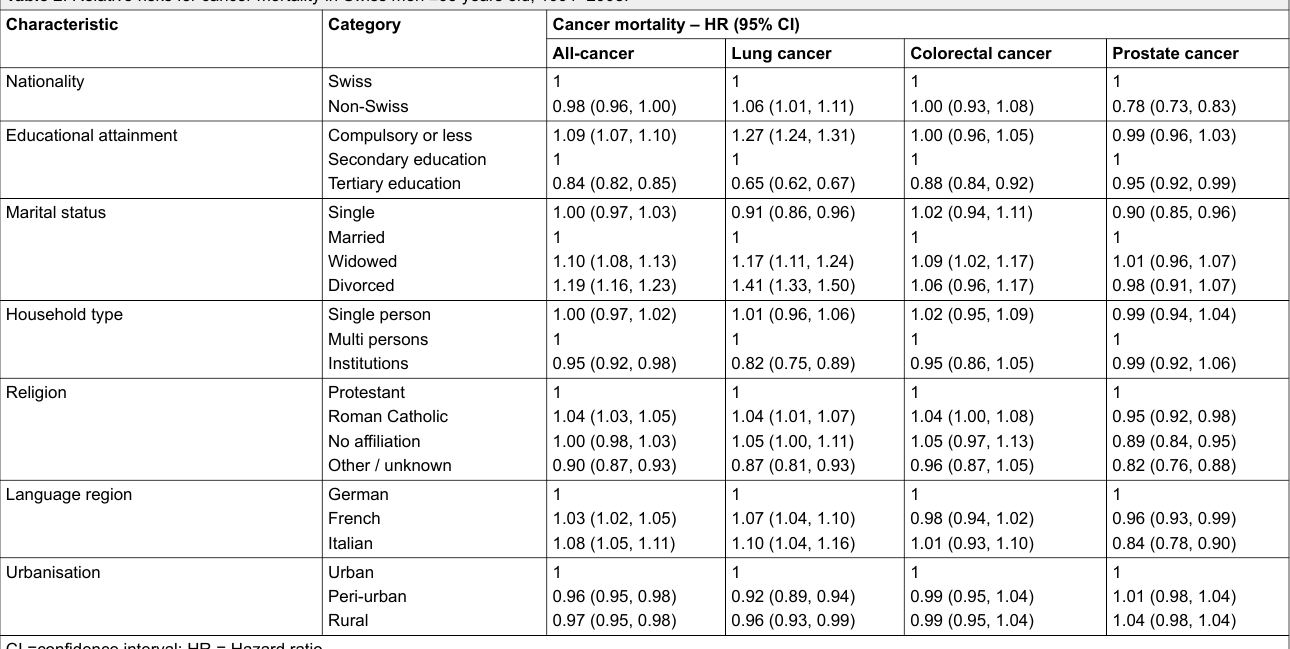
Table 2 : Relative risks for cancer mortality in Swiss men ≥65 years old,